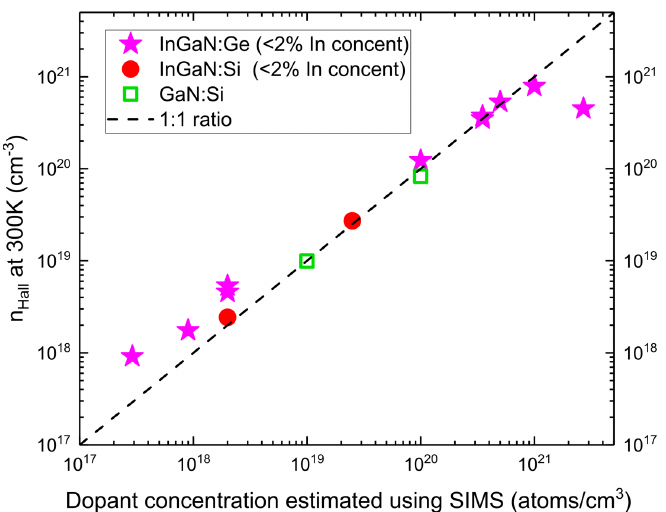
Figure 5. Electron concentration extracted from Hall measurement (n Hall ) conducted at room temperature for about 300 nm-thick layers grown on semi-insulating GaN/Al 2 O 3 templates as a function of dopant concentration estimated using secondary ion mass spectroscopy (SIMS) measurements performed on separate calibration samples. Results of Hall concentration presented in [29]. Data obtained for InGaN:Ge, InGaN:Si and GaN:Si are presented using blue stars, red circles and magenta squares, respectively. The 1 to 1 n Hall electron concentration to dopant concentration is marked by a dashed line.